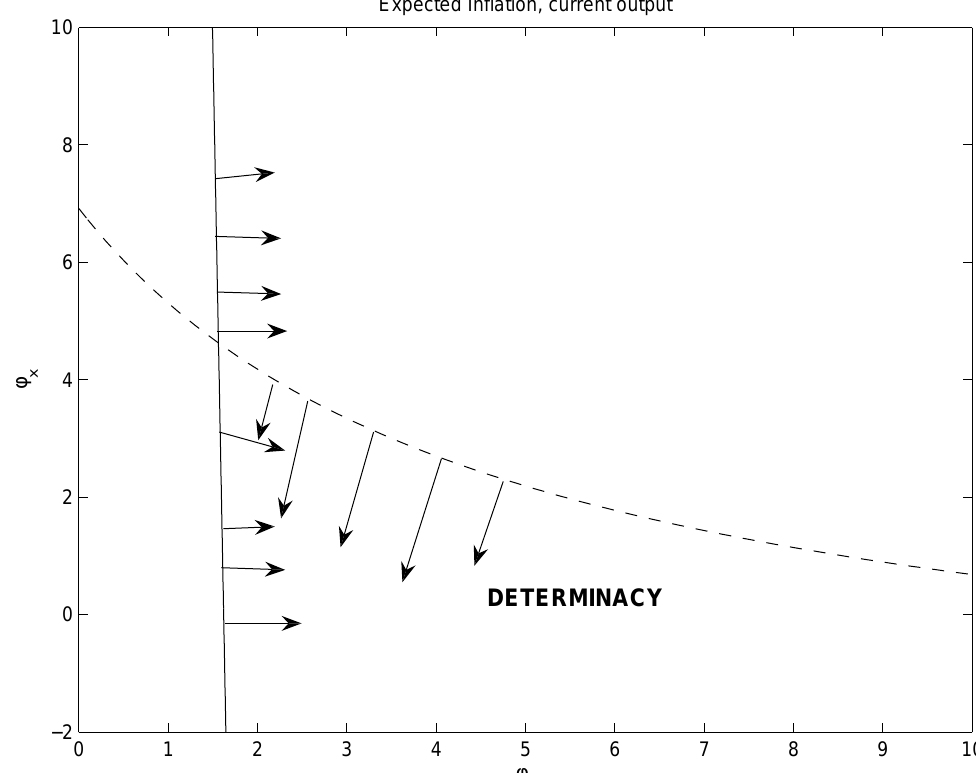
Figure 3. Determinacy regions for a Taylor rule with expected inflation and current